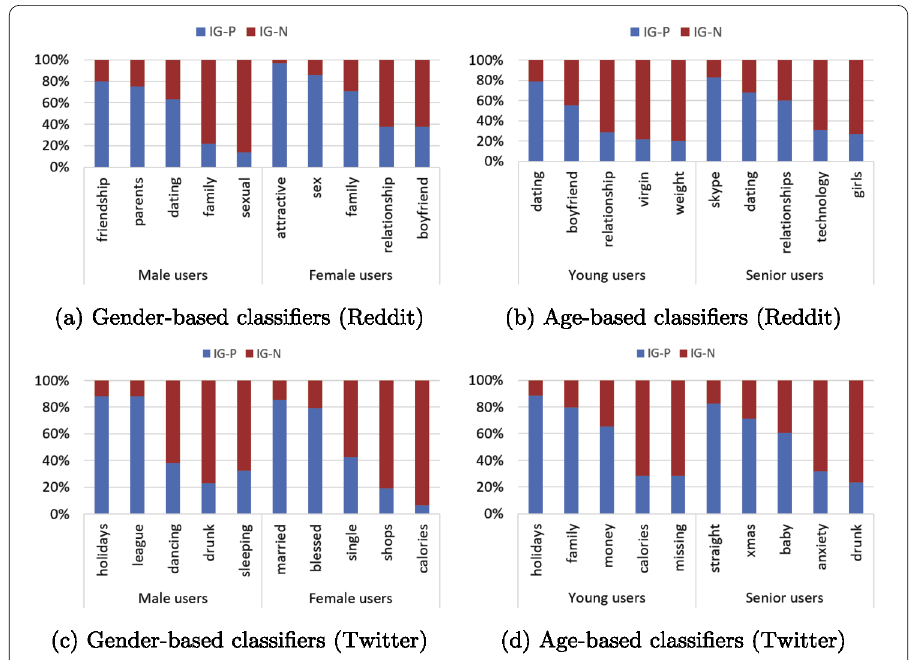
Figure 4 Examples of words that show contrasting information gain values depending on the users traits and polarity of their occurrences. Each bar corresponds to a word and indicates the relative importance of its IG values in positive (blue part) and negative (red part) posts